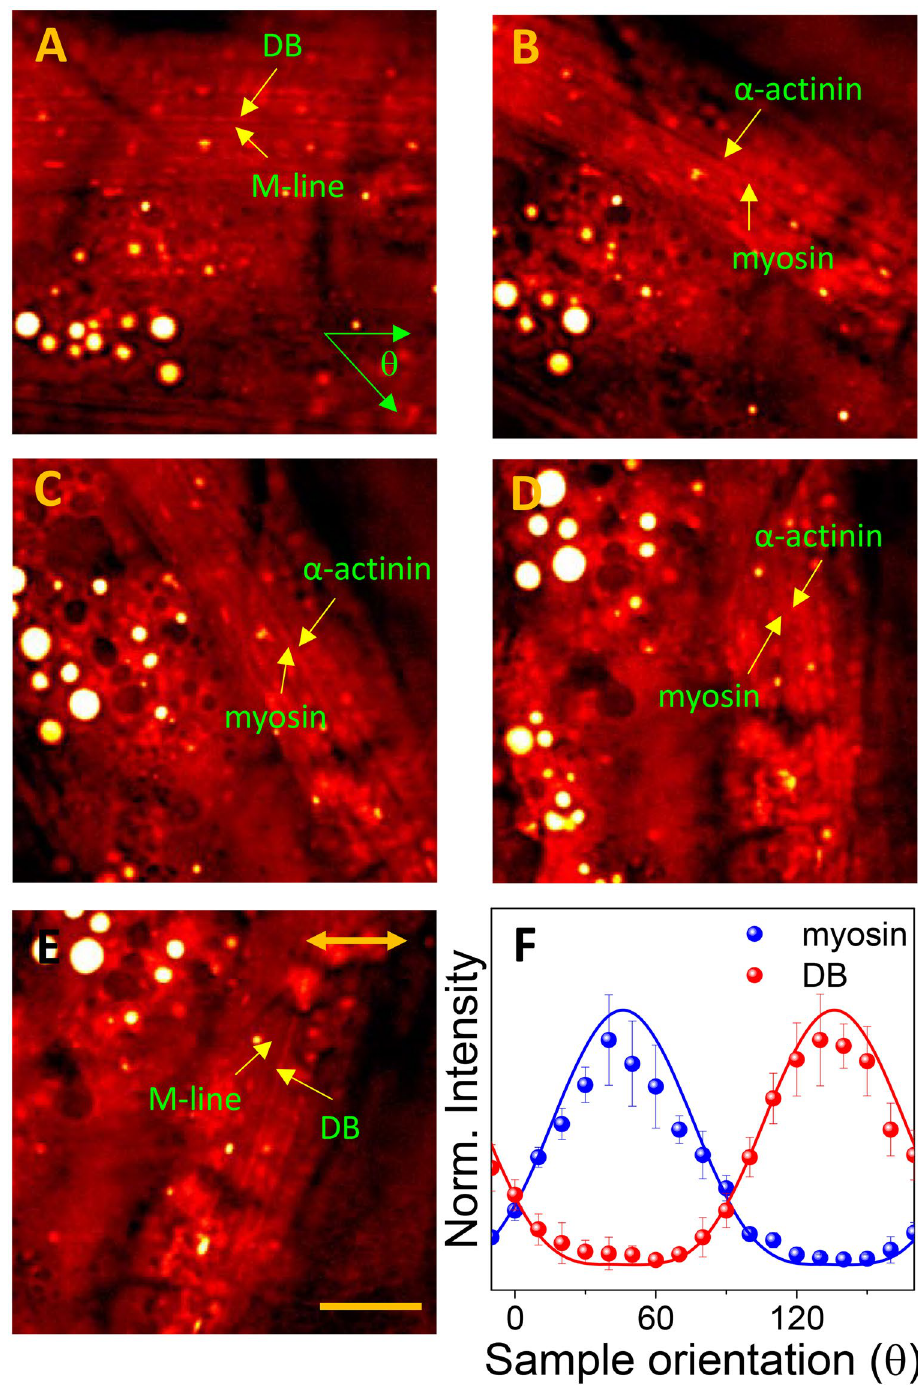
Figure 3. Polarization-dependent appearance of muscle subunits. The spCARS images of body wall muscle near the vulva of WT C. elegans for the 2860 cm − 1 vibration mode, when the angle of the sample with respect to the excitation beam θ was ( A ) 0°, ( B ) 30°, ( C ) 60°, ( D) 90°, and ( E ) 120°. The scale bar represents 20 μ m; Double-sided arrow indicates the direction of the polarization of two incident beams. (F) Polarization of the spCARS myosin (blue) and Z-line (red) signals as a function of the sample